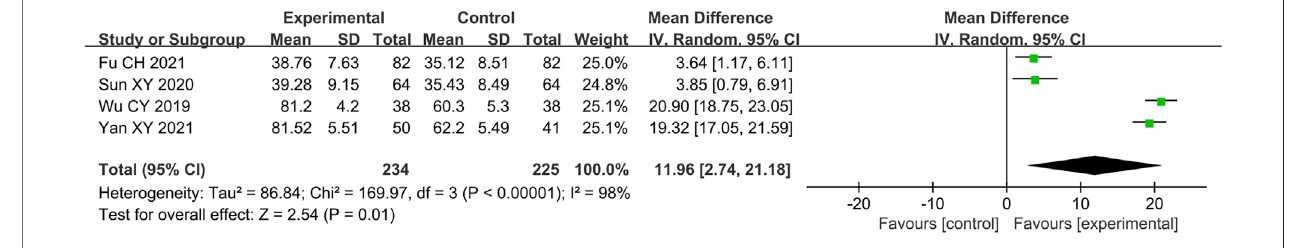
FIGURE 5 | Forest plot of NO.